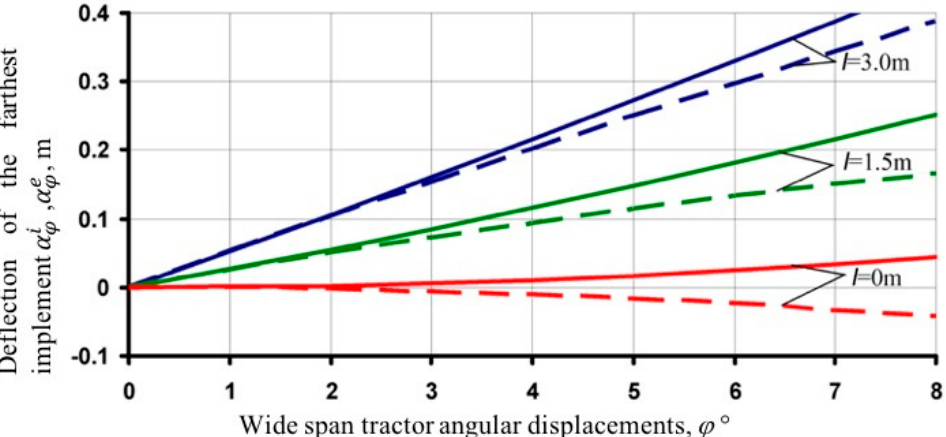
Figure 3. Inner α i ϕ (–) and outer α e ϕ ( − − − ) displacements of the peripheral working implement of the wide span tractor, depending on its angular deviation ϕ for di ff erent values l .